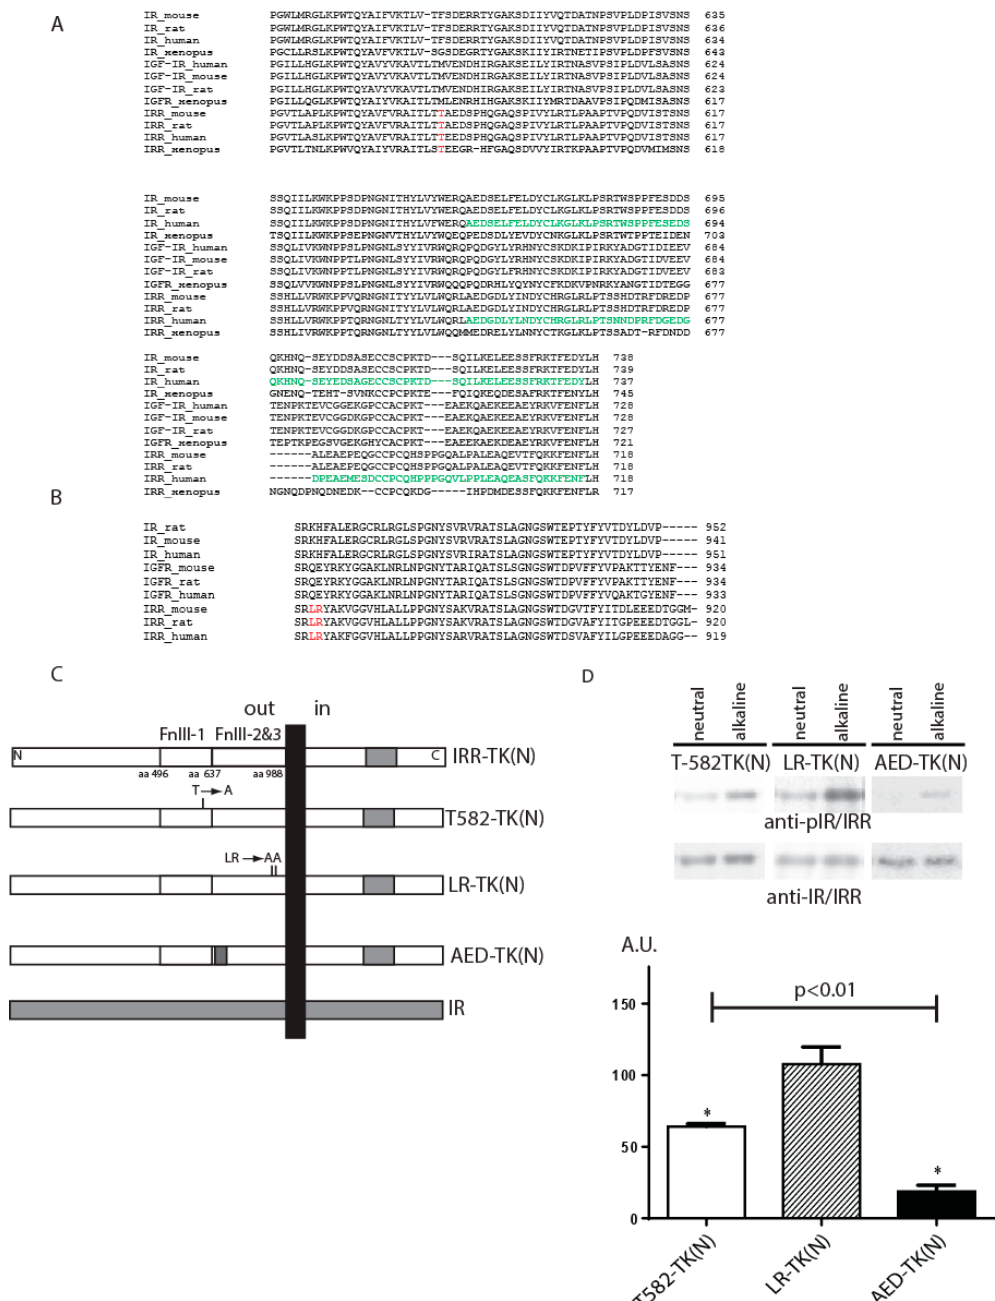
Figure 1. The role of T582, L868, R869 (red) and region (646–716) (green) within fibronectin repeats domains. ( A ) Alignment of insulin receptor (IR), insulin-like growth factor receptor (IGF-IR) and insulin receptor-related receptor (IRR) sequences with indication of T582 and region (646–716). ( B ) Alignment of IR, IGF-IR and IRR sequences with indication of L868 and R869. ( C ) Domain models of the 6xHis-tagged T582-TK(N), LR-TK(N), and AED-TK(N) alanine mutants or chimera with partial tyrosine kinase domain swapping TK(N). ( D ) Quantitative analysis of the activation of indicated constructs by alkali in comparison with IRR-TK(N) as 100%. The Western blots with samples from in vitro autophosphorylation assays were blotted with anti-pIR/IRR antibodies and, after stripping, with anti-IR/IRR antibodies. Quantitative analysis of the activation of the constructs performed as described in Materials and Methods. Asterisks indicate p < 0.05 in comparison with the IRR-TK(N). Values are means ± SE ( n ≥